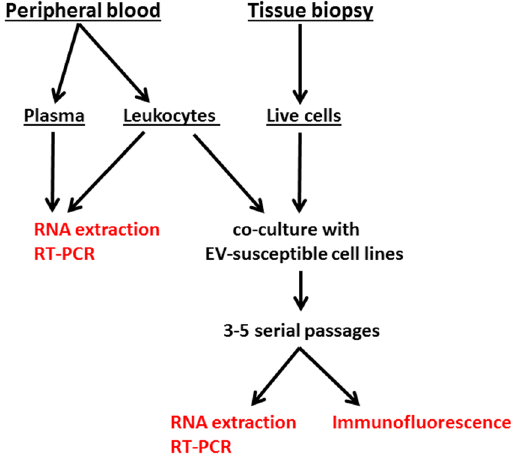
Figure 1. Representation of the integrated procedure used for detecting enteroviruses (EVs) in patients diagnosed with post-polio syndrome (PPS), type-1 diabetes mellitus (T1D), chronic viral cardiomyopathy (CVC). Venous peripheral blood or tissue biopsies were used as clinical samples. Plasma and blood leukocytes were tested directly by molecular assays (left side). Blood leukocytes and live cells obtained from biopsies were co-cultured with cell lines (right side). Cell cultures were serially passaged 3 to 5 times. RNA was then extracted from medium of cultured cells. Molecular assay were used to detect the viral genome. For each